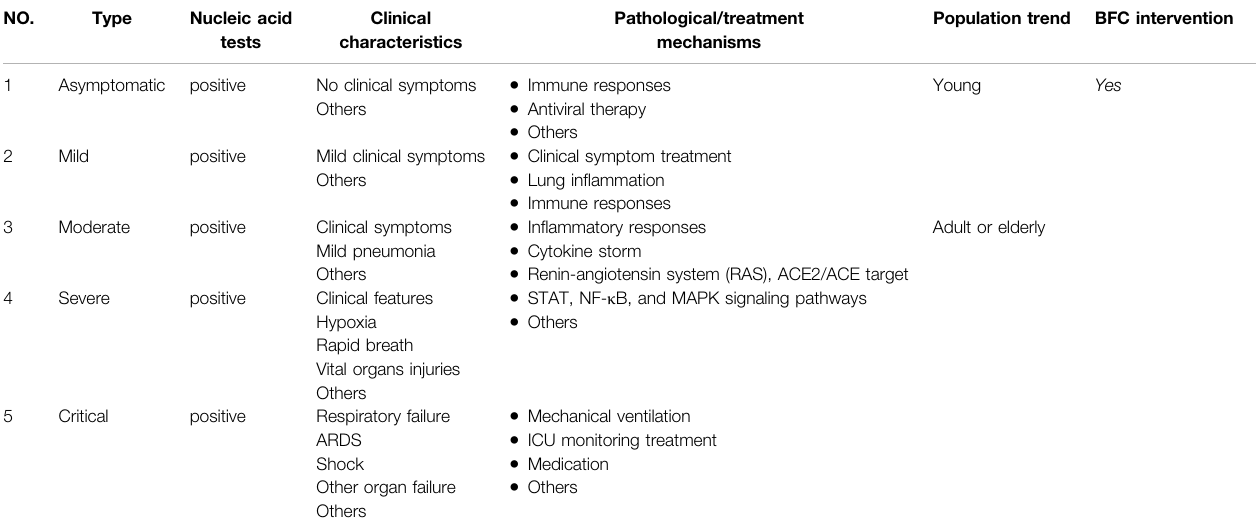
TABLE 2 | The clinical characteristics and corresponding pathological or potential treatment mechanisms of COVID-19 intervened by BFC